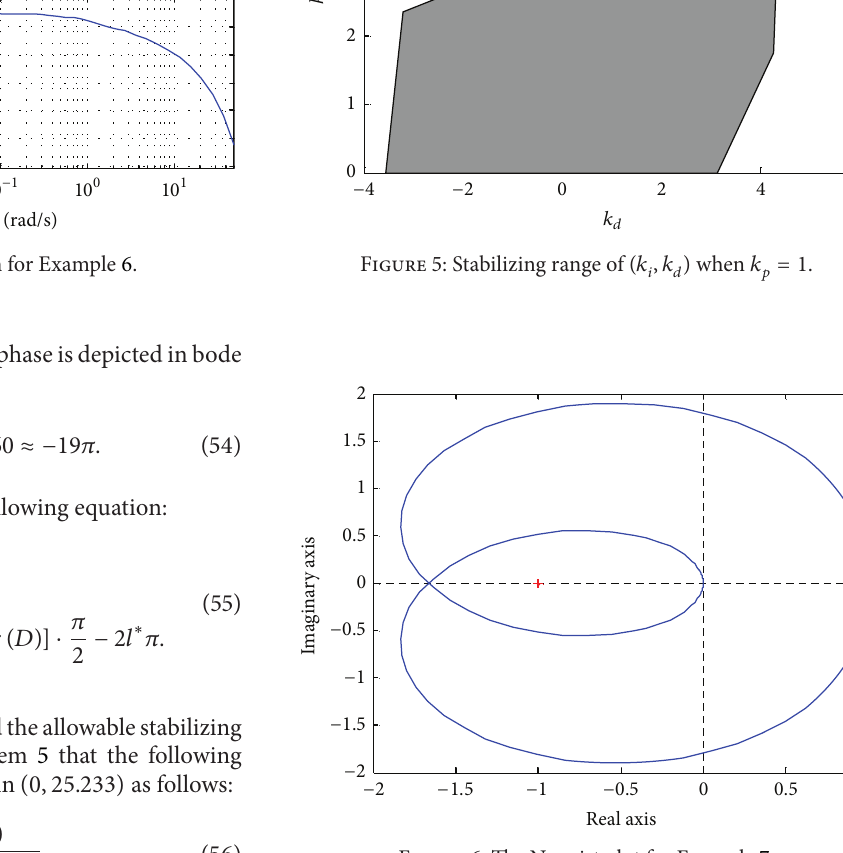
Figure 6: The Nyquist plot for Example